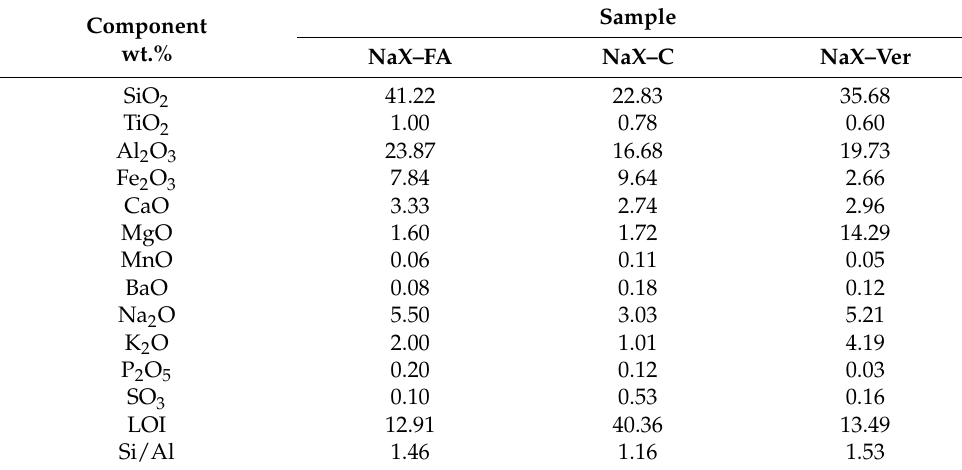
Table 1. Chemical composition of the samples, as obtained from XRF.